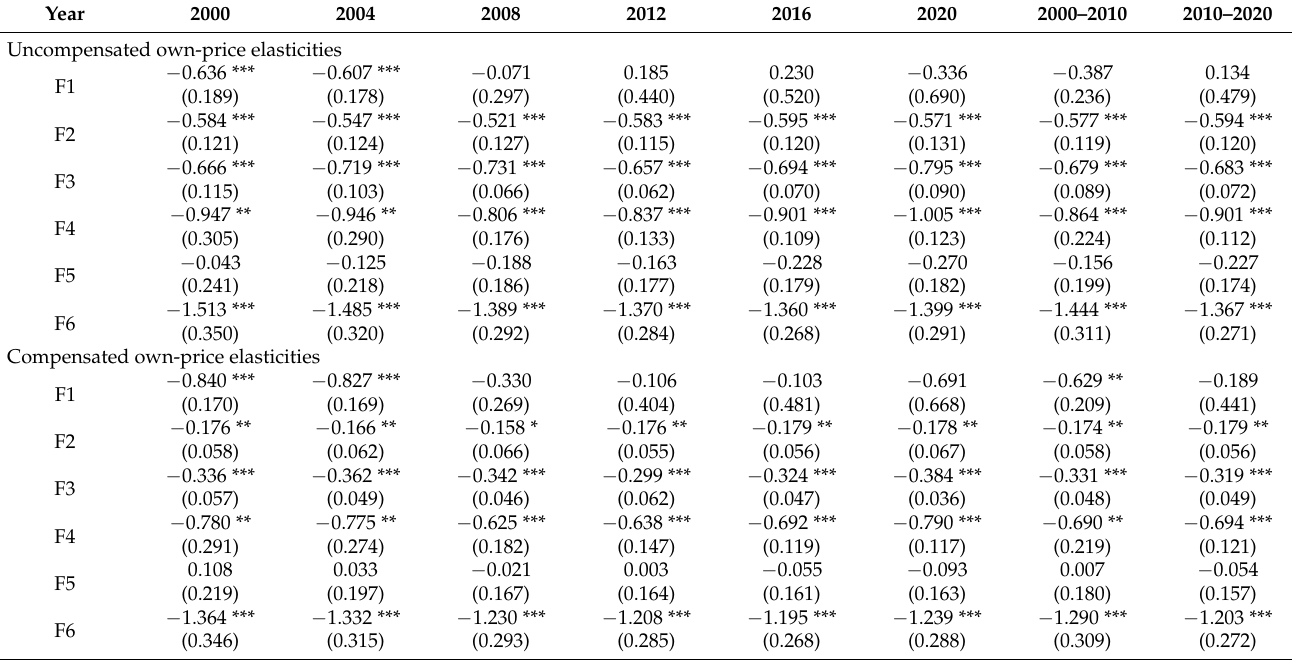
Table 4. Own-price elasticities for various food groups from 2000 to